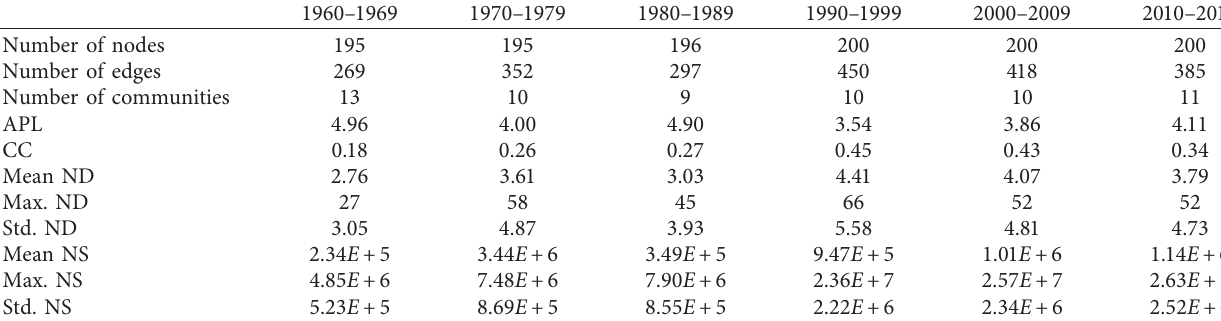
Table 1: Descriptive statistics regarding the GMN.